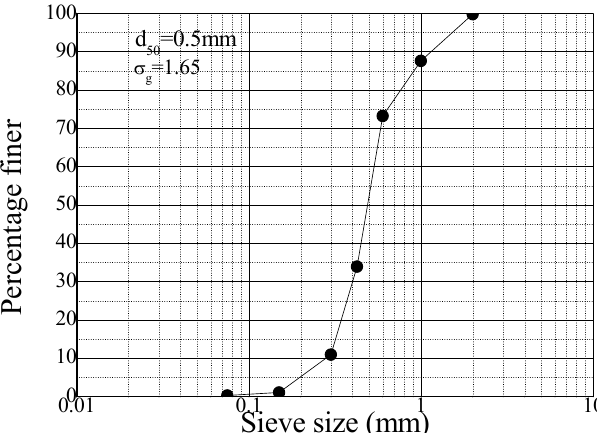
Figure 2. Grain distribution curve for the sand used in this study. Table 1. Characteristics of the sediment mixture and flow conditions for this study. All experiments were characterized by clear-water conditions. Sand d 50 Sand σ g Flow Depth h Discharge Q Reynolds Number Seepage Discharge